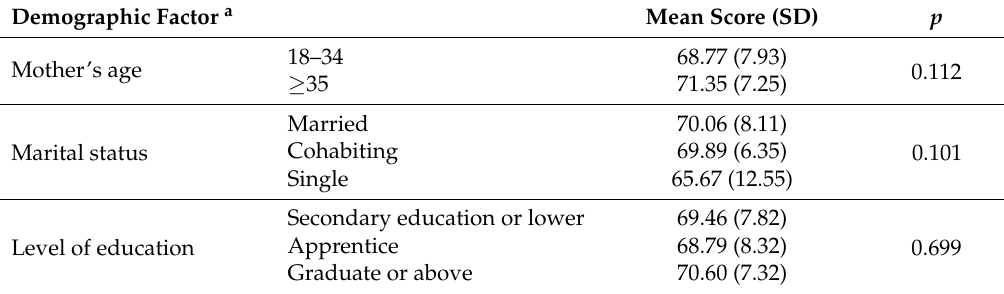
Table 3. Differences in attitudes towards breastfeeding by demographic factor, as determined by Iowa Infant Feeding Attitude Scale scores (IIFAS-t). IIFAS scores range from 17 to 85 with higher scores reflecting more positive attitudes on